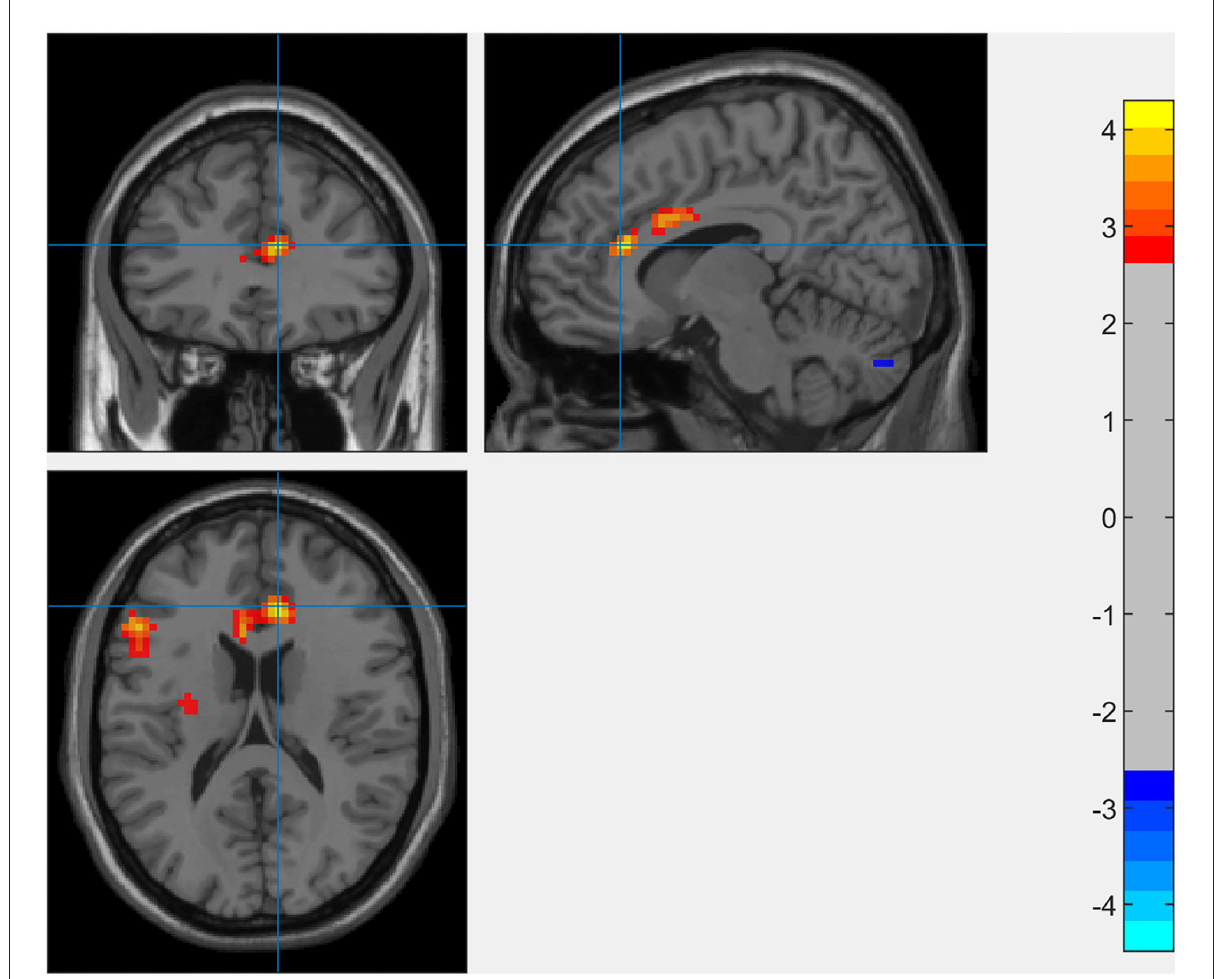
FIGURE3 Whole-brain analysis of the interaction between SCCS and SES when predicting spontaneous activation of the brain (GRF-corrected p < 0.005 at the voxel level with p < 0.05 at the cluster level).